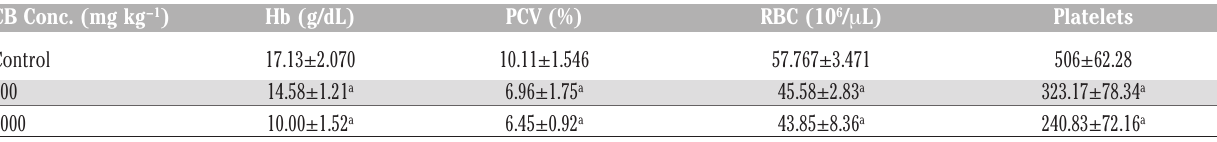
Table 2. Effect of oral administration of class bitters ® on hematological parameters.